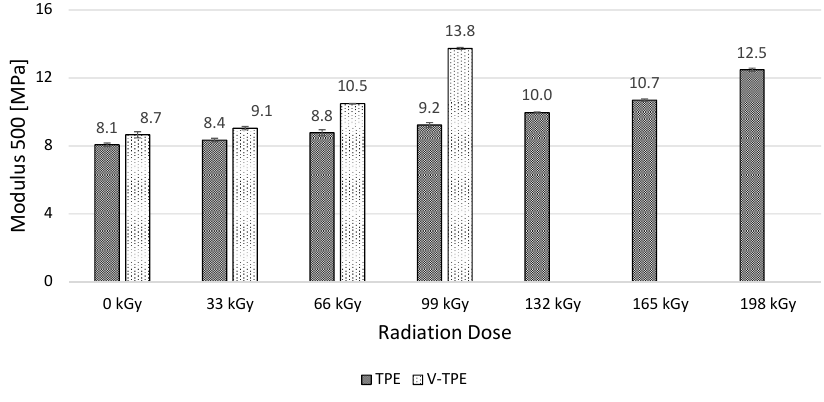
Figure 15. Modulus 500—TPE-E, V-TPE-E.